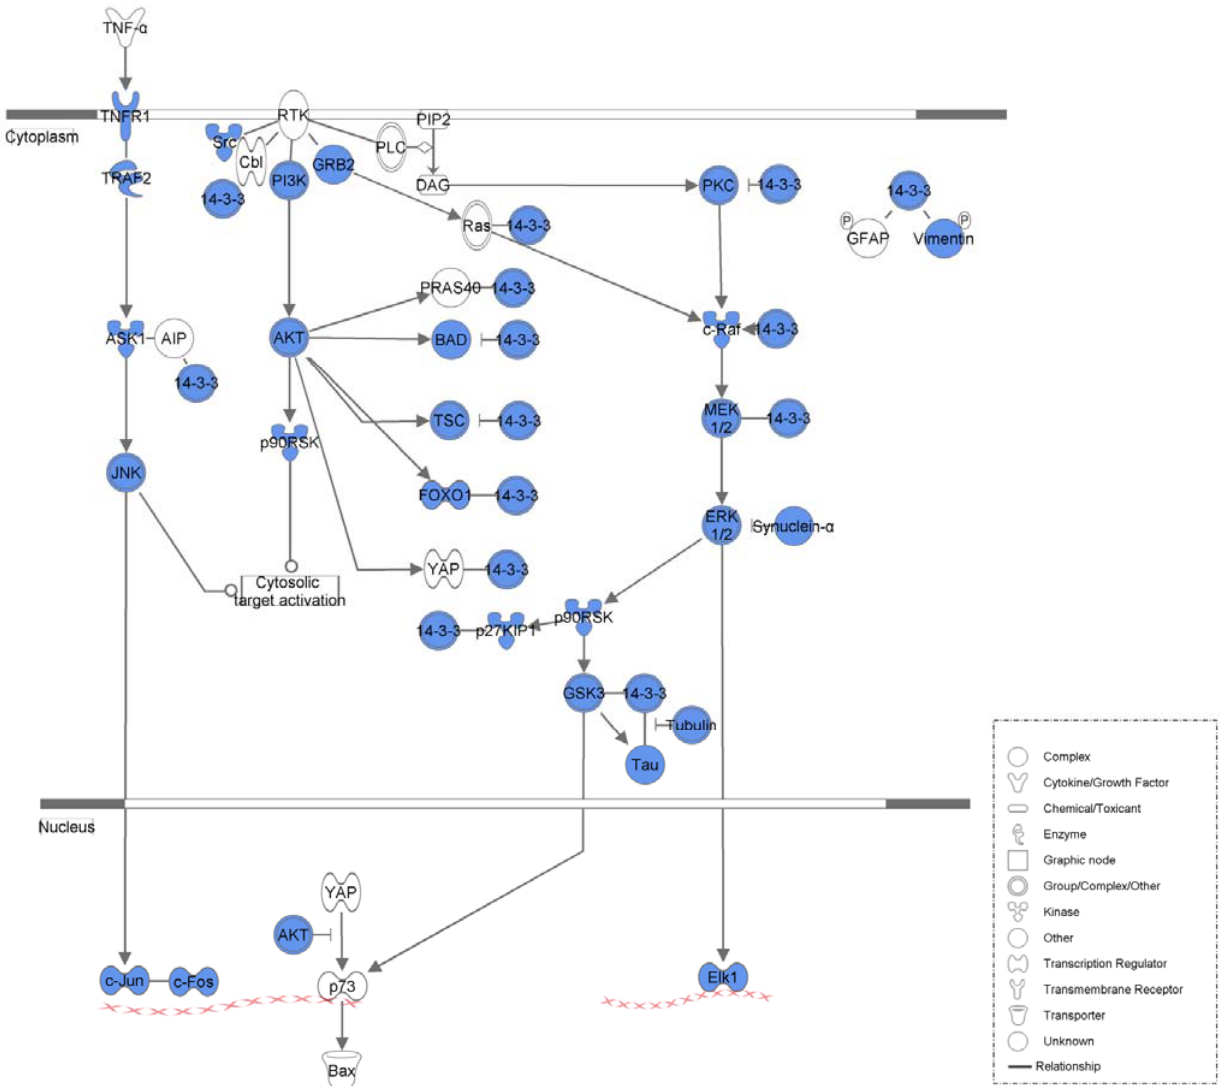
Figure 5. 14-3-3-mediated signaling associated with the common network. Blue legends represent proteins contained in the common